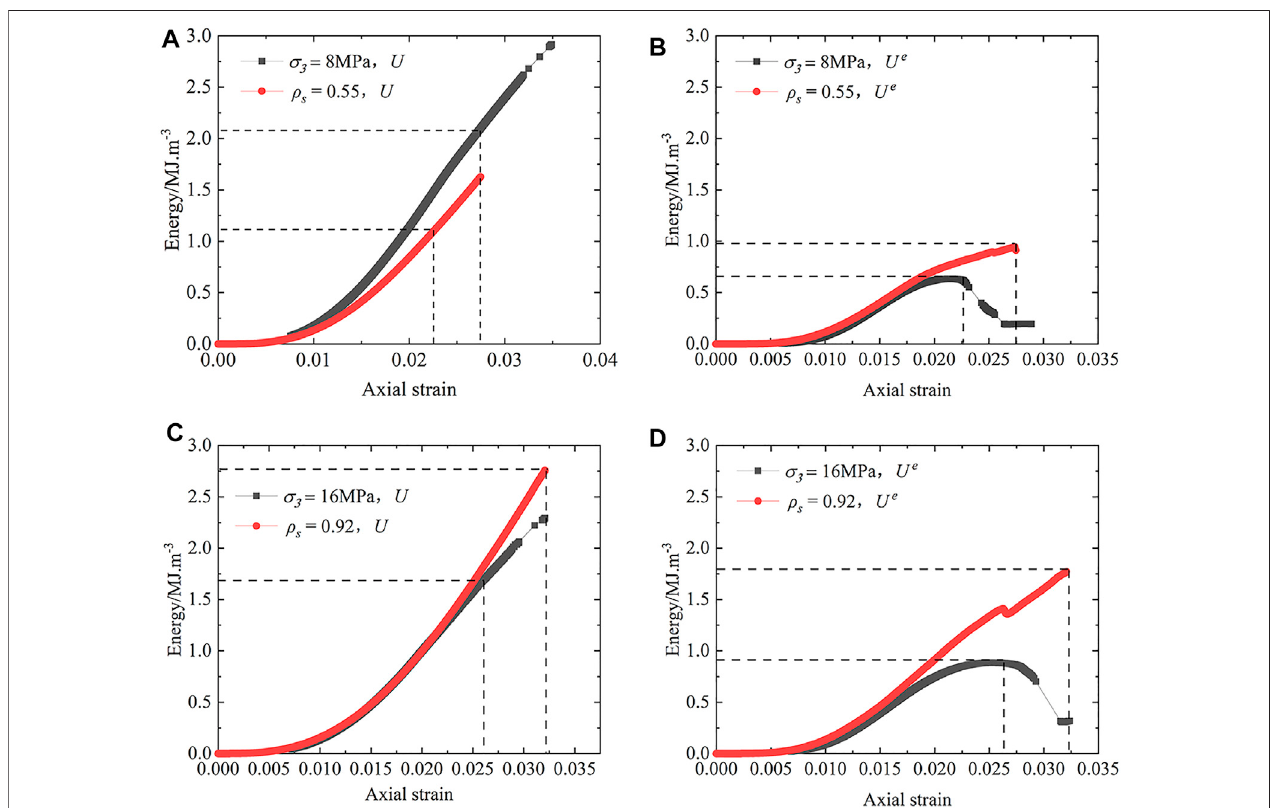
FIGURE10| Comparison ofenergyevolutioncurvebetweenthetwoconditionsunderthesamecon fi ning stressstandard. (A) Totalabsorbedenergy(8 MPa); (B) elastic energy (8 MPa); (C) total absorbed energy (16 MPa); (D) elastic energy (16 MPa).